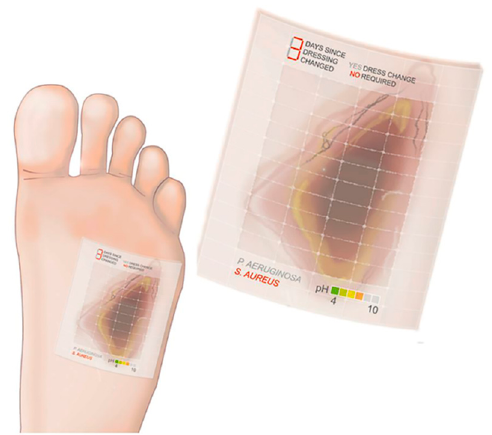
Figure 9. The possible evolution of MSA/MSS, designed for wounds in the future: the MSA/MSS is incorporated into the wound bandage, monitoring the size of the wound, pH changes, bacterial contamination, etc. Reused form [181]. Reproduction permission granted by Elsevier.